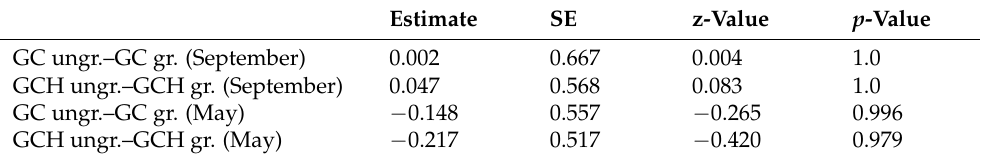
Table A27. Differences in activity densities of red list carabid beetles, comparing the grazed pas- tures and ungrazed strips of the grass–clover (GC) and the grass–clover herbs (GCH) in May/June and September.